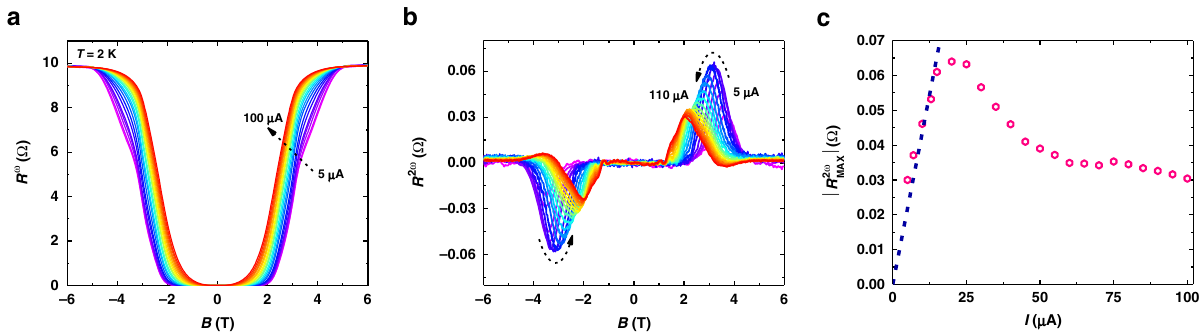
Fig. 3 Current-dependent nonreciprocal charge transport in atomically thin NbSe 2 . a , Current-dependent fi rst harmonic signal of the fi ve-layer NbSe 2 device at T = 2 K. In the small current regime ( I 0 ≤ 15 μ A), the R ω -B curves are nearly unchanged with the increase of I 0 , suggesting a negligible change of the superconducting properties due to the increasing current. While in the larger current regime ( I 0 ≥ 20 μ A), prominent expansion of the nonzero region in the R ω -B curves emerges, indicating a non-negligible breaking of superconducting states by increasing I 0 . b , Corresponding current-dependent second (cid:1) (cid:1) (cid:1) (cid:1) as a function of applied current, showing a linear increase at small current harmonic signal of NbSe 2 at T = 2 K. c , Deduced maximum value R 2 ω MAX